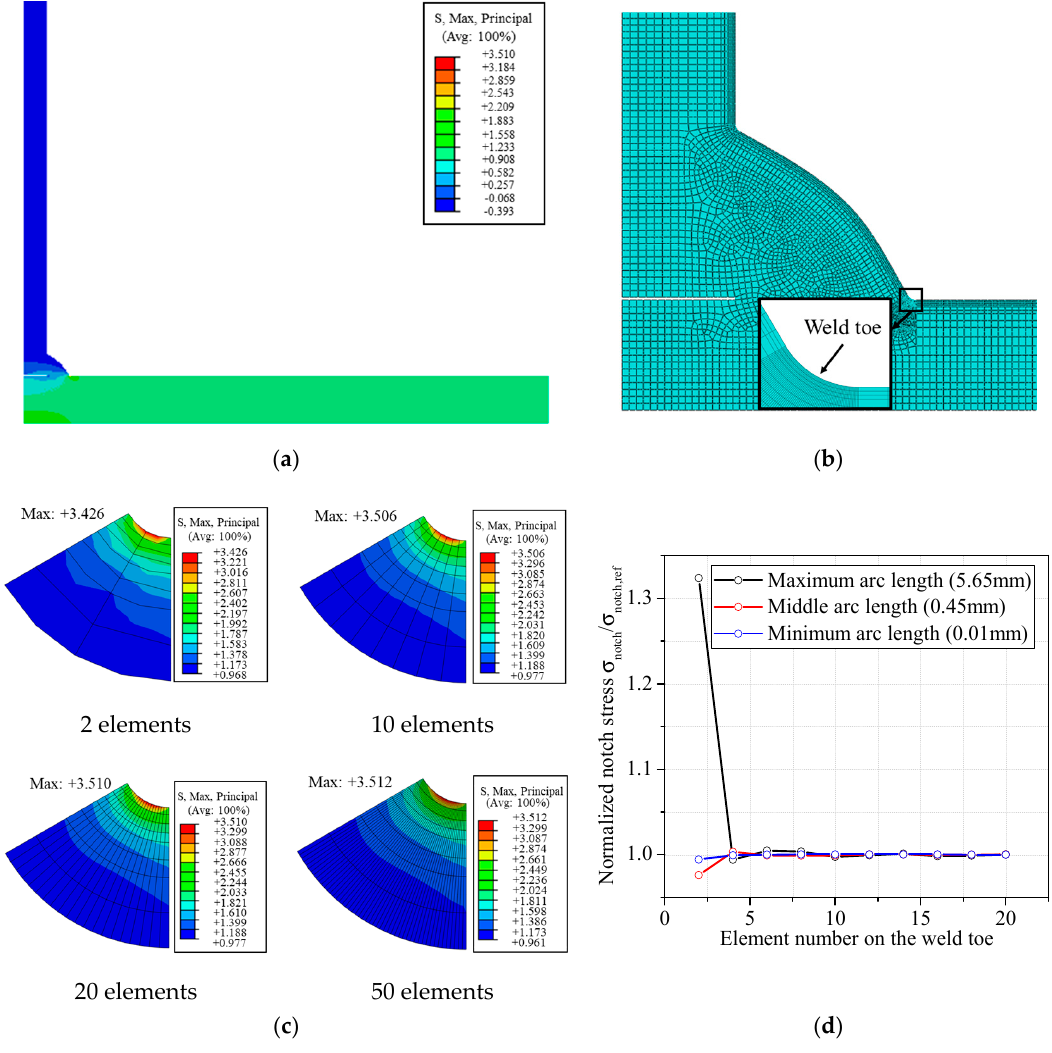
Figure 3. Finite element model (unit: MPa): ( a ) global model ( b ) typical global and local meshes; ( c ) mesh discretization; ( d ) convergence analysis.